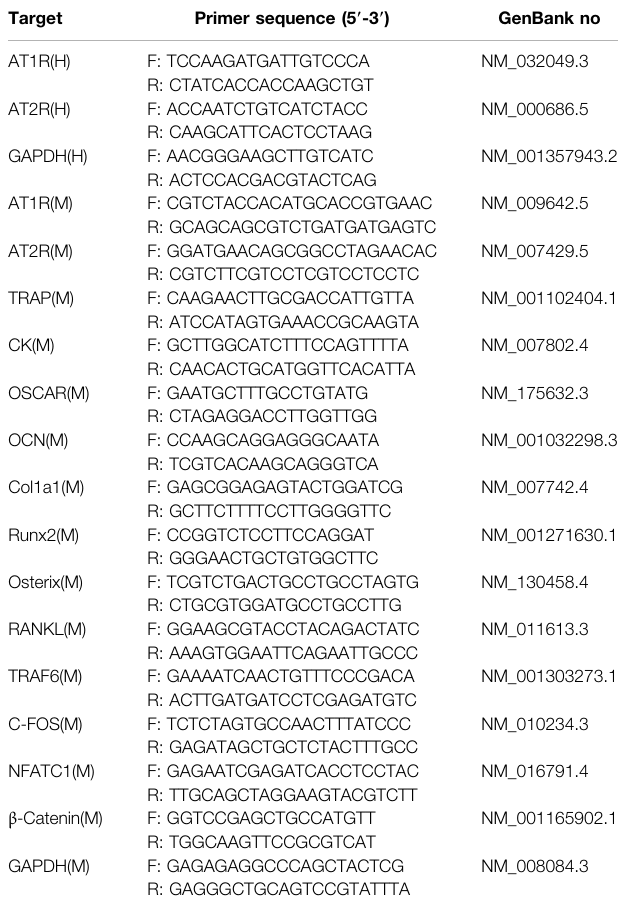
TABLE 1 | Primers sequences for reverse transcription-quantitative polymerase chain